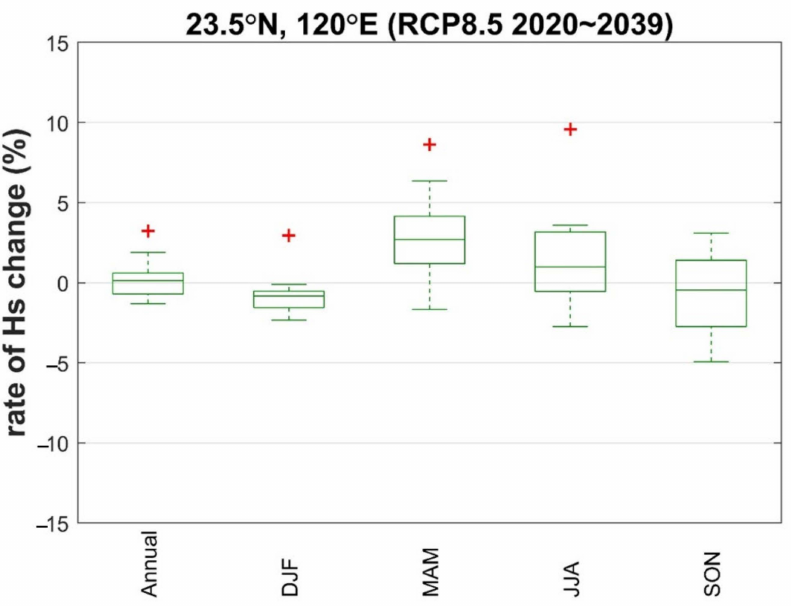
Figure 22. Box plot of rate of change in the seasonal mean of significant wave heights for each GCM, with respect to the reference period from 1980 to 2004 in the region of Taiwan at 23.5 ◦ N, 120 ◦ E for various future periods (2020–2039) and scenarios